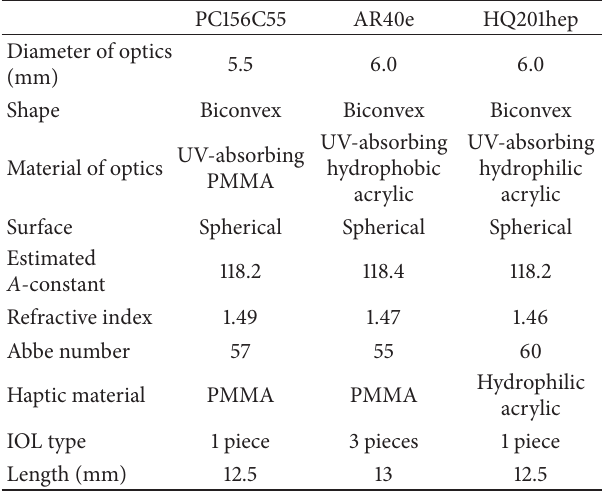
Table1:CharacteristicsoftherigidPMMA,hydrophilicacrylic,and hydrophobic acrylic IOLs